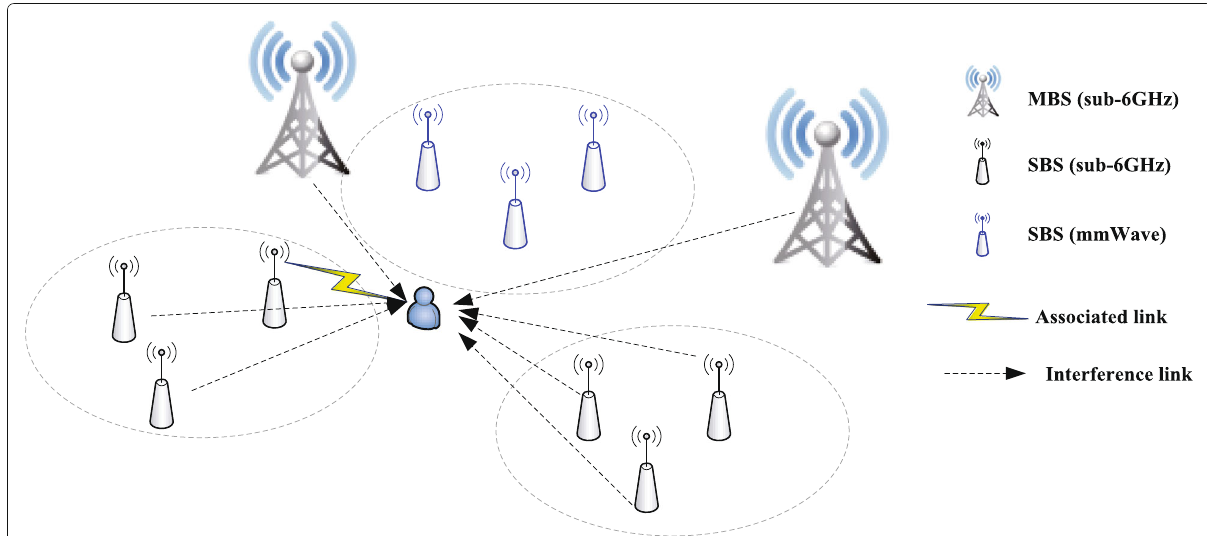
Fig. 3 The condition that UE associates with sub-6 GHz SBS tier (cid:8) γ β T ki β , k (cid:7)= i , k ≤ N F ki = , where β ki = G ki h ki (cid:3) x ki (cid:3) − α k kk 0, otherwise consists of the antenna gain, channel gain, and path loss from transmitter k to receiver i . The elements in b are auxiliary variables which can be considered as the nor- malized SINR threshold for every receiver and b = (cid:9) (cid:10) γ γ γ T N 0 β T N 0 β T N 0 β . The power control vector , , ..., ( N + M )( N + M ) 11 22